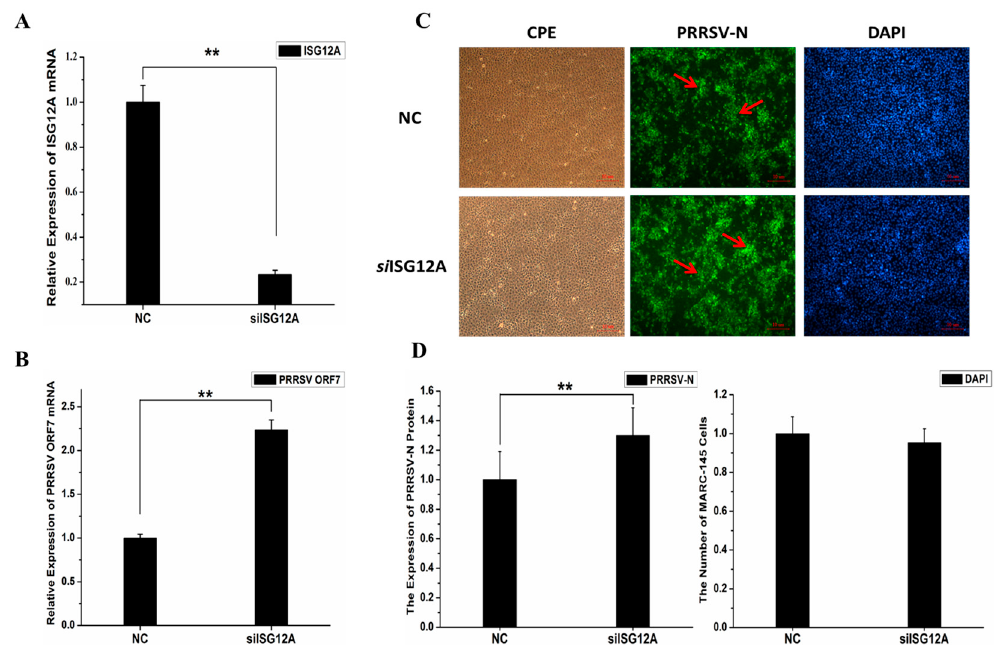
Figure 6. Decreased basal level of porcine ISG12A using siRNA promoted PRRSV replication. Nagtive control (NC) and siRNA were transfected into MARC-145 cells 24 h, after that the cells were infected with PRRSV, and the cells were collected at 36 hpc. ( A ) The relative level of porcine ISG12A mRNA in MARC-145 cells after 36 hpc; ( B ) The relative level of PRRSV ORF7 mRNA in MARC-145 cells at 36 hpc; ( C ) Result of the IFA. “CPE” indicates the observed cytopathic effects in the bright field; “PRRSV-N” represents the results of fluorescence-stained cells with the antibody against PRRSV N protein (green marked by red arrows); “DAPI” represents the cell density by nuclear staining using DAPI (blue); (scar bar: 10 µm); ( D ) The statistical results of the IFA, the number of fluorescence positive cells were normalized to the total cell number (DAPI-staining cells) to evaluate the relative PRRSV level. Student’s t -test: ** p < 0.01.